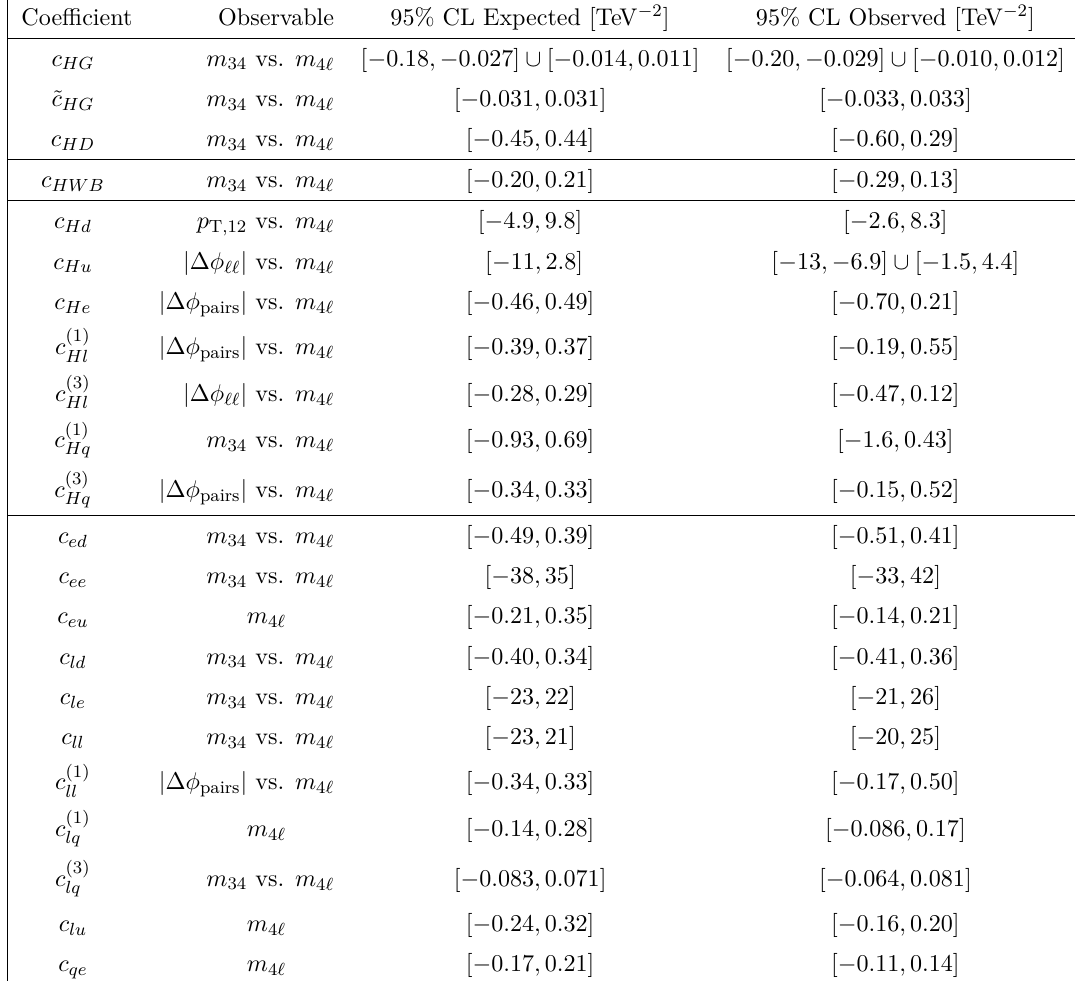
Table 3 . The expected and observed confidence intervals at 95% CL for the SMEFT Wilson coefficients, including both the linear and quadratic terms. The most sensitive observable indicated for each coefficient is used for the constraints. Only one coefficient is fitted at a time, with all others set to